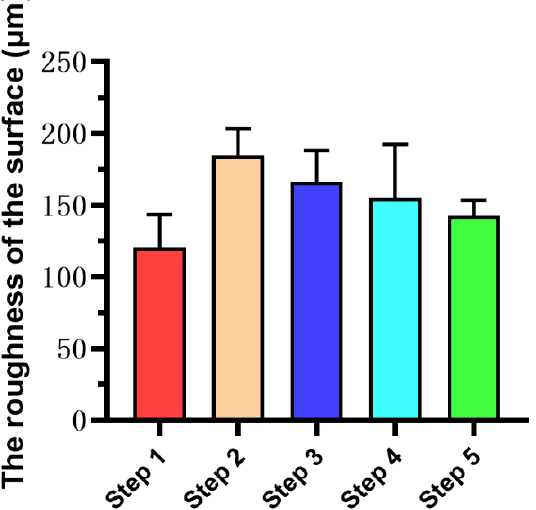
Figure 6. The roughness of the surface of teeth in each step. There was no statistical difference between steps. The surface roughness of Step 5 was similar to that of Step 1. The surface roughness of the samples of Step 2 increased due to demineralization, and the surface roughness of the samples was decreased after treatment with Icon-Etch (Step 3) and Icon-Dry (Step 4).